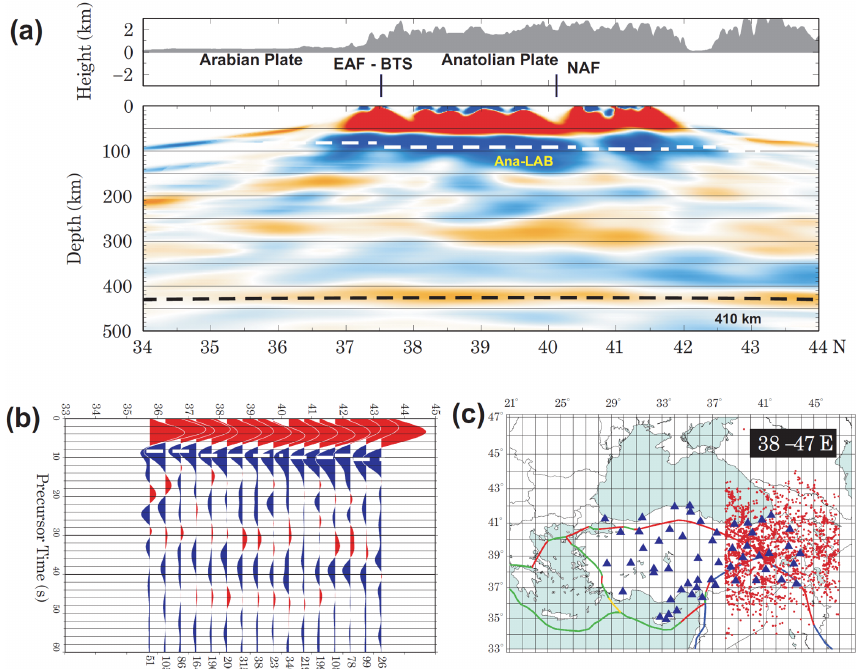
Figure 7. Same as Fig. 5 for a north–south profile between 38 and 47 ◦ E (eastern Anatolia). A flat Anatolian LAB is visible; no subducting LAB can be